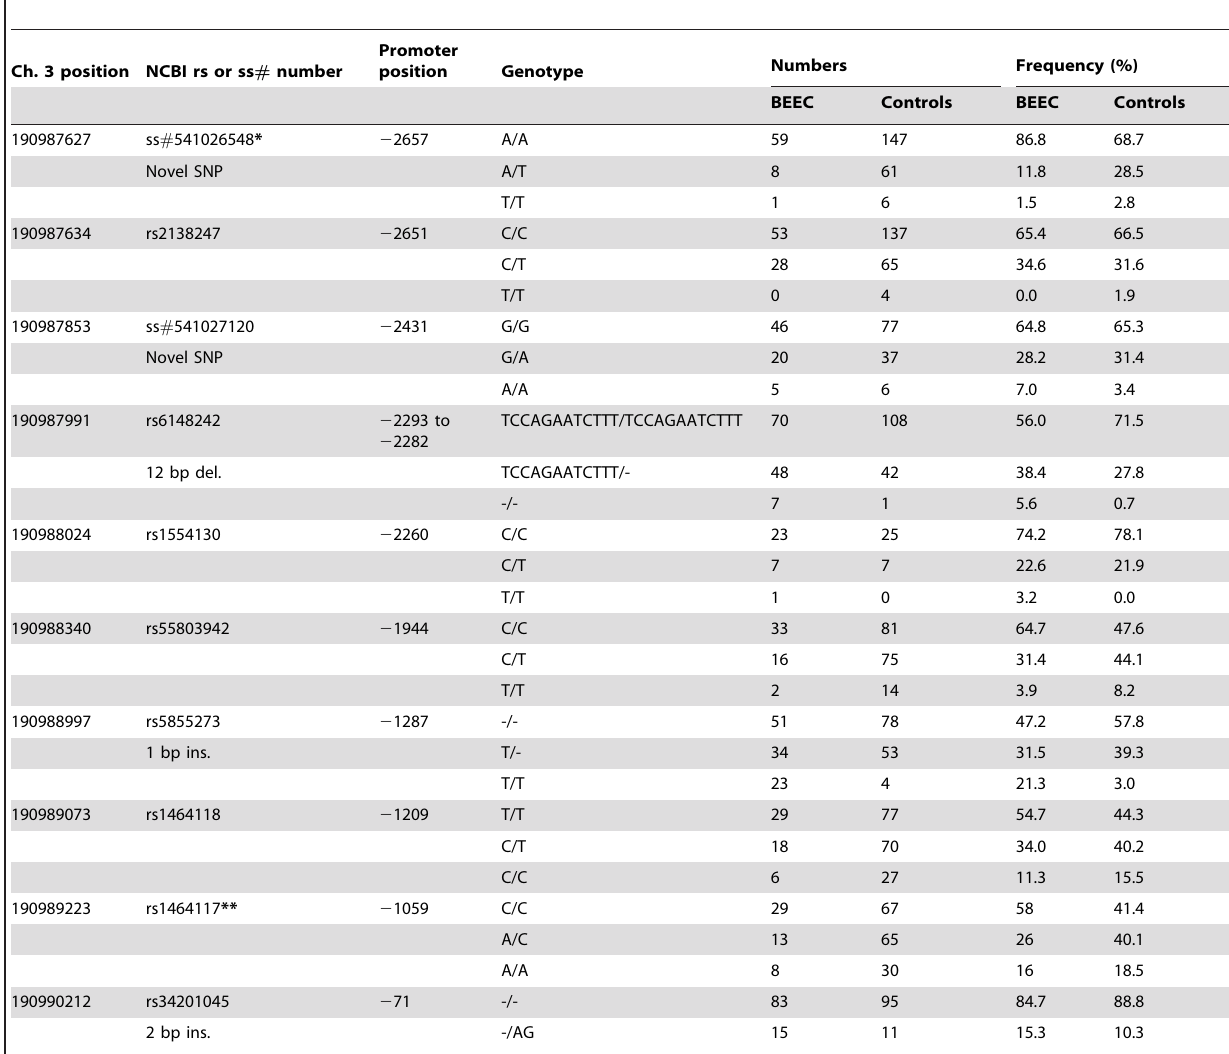
Table 2. Single nucleotide polymorphisms and insertion/deletion polymorphisms in D Np63 promoter found in BEEC patients and normal